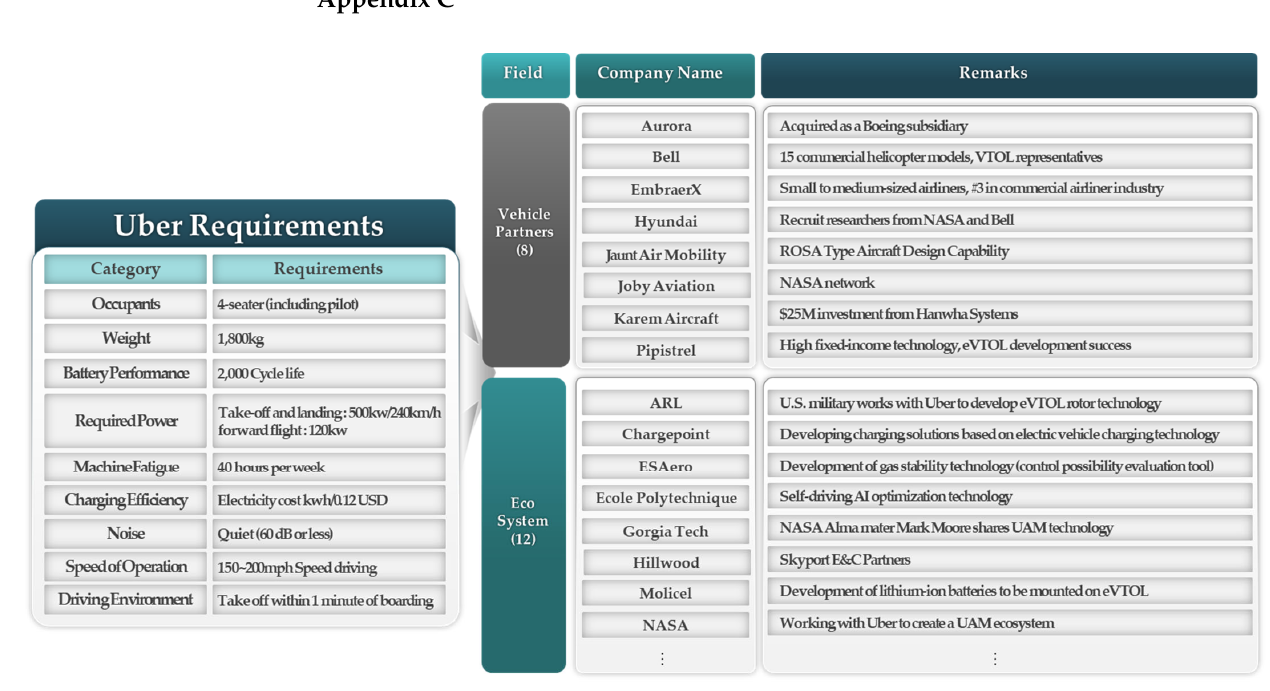
Figure A3. Uber requirements.